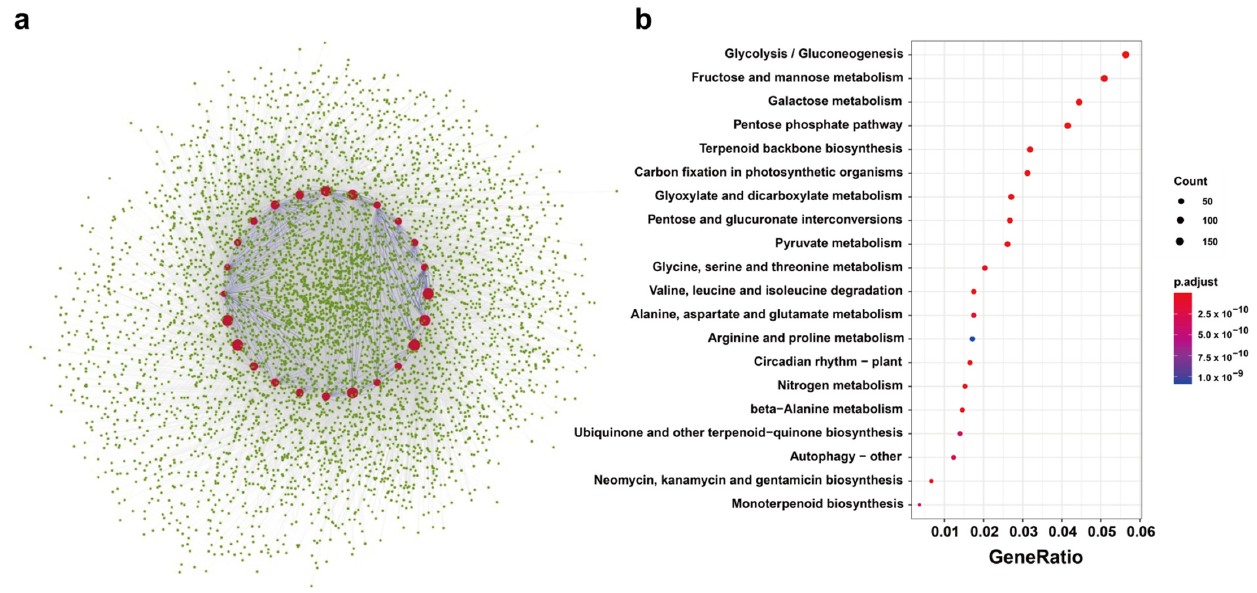
Figure 5. The TPS-protein interaction network analysis in B. napus . ( a ) The PPI network of BnTPS proteins. Red circles represent the BnTPS proteins and the green circles represent proteins that interacted with BnTPS proteins. The blue lines indicate the interaction between BnTPS proteins and the grey lines indicate the interaction between BnTPS and other proteins. ( b ) KEGG pathway analysis of proteins that interacted with BnTPS proteins. The color bar shows the p.adjust value from low (red) to high (purple).